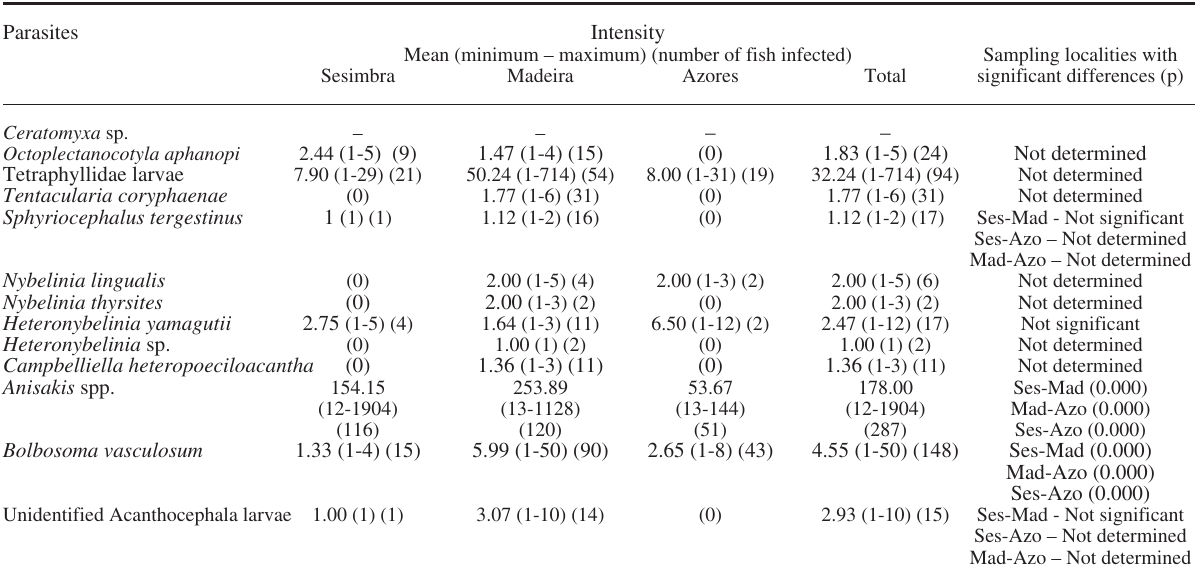
Table 5. – intensity [mean (range)] of infection of Aphanopus carbo and statistical significance between the values obtained at the three sampling localities (Ses, Sesimbra; Mad, Madeira; azo, azores) determined by the Mann-Whitney test. Parasites intensity Mean (minimum – maximum) (number of fish infected) Sampling localities with Sesimbra Madeira azores total significant differences (p) Ceratomyxa